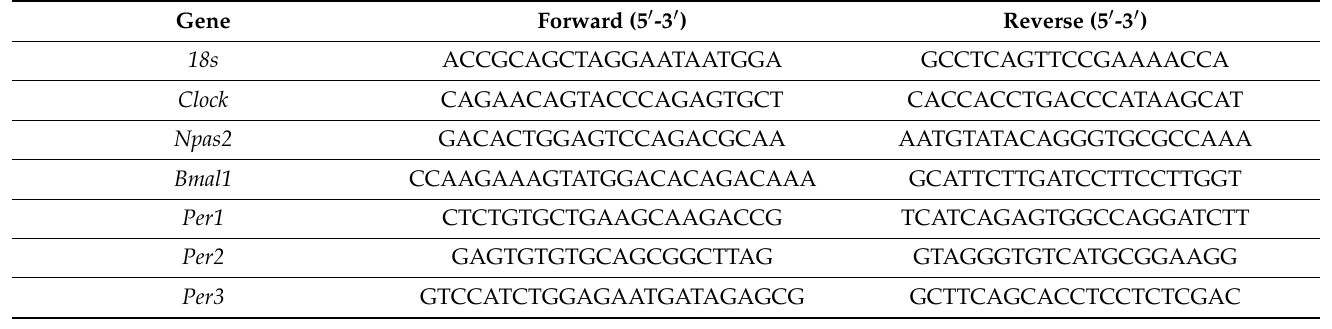
Table 2. Primer sequence for circadian gene expression analyzed by qPCR for the NAc, SCN, and VTA.